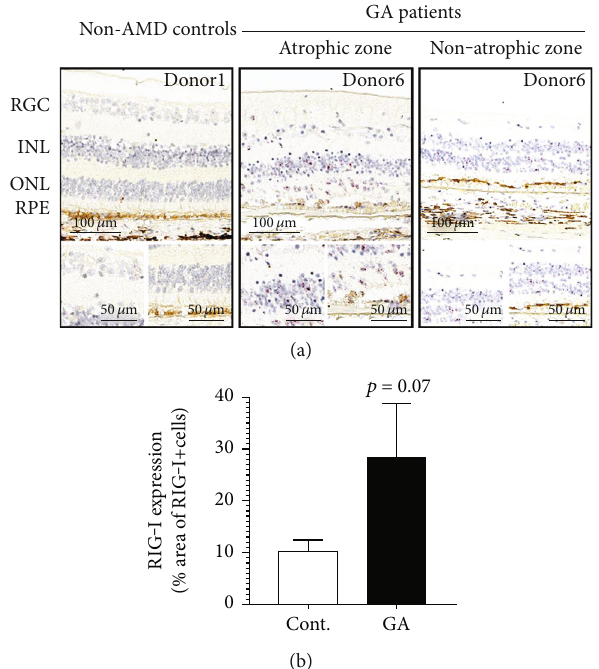
Figure 4: RIG-I mRNA is elevated in patients with GA. (a) The elevation in the levels of RIG-I mRNA in patients with GA relative to non- AMD controls was observed using RNAscope. Low levels of RIG-I signal (red dots) were detected in non-AMD control patients, whereas elevated signals were detected in RGC, ONL, INL, and RPE layers of patients with GA. Scale bars are indicated. n = 3/group , patient information is listed in Supplementary Table 1. DAPB was used as negative control (see Supplementary Figure 1D). In addition, the RIG-I signal in the macular region was analyzed by HALO, with the % area of RIG-I positive signals being shown in